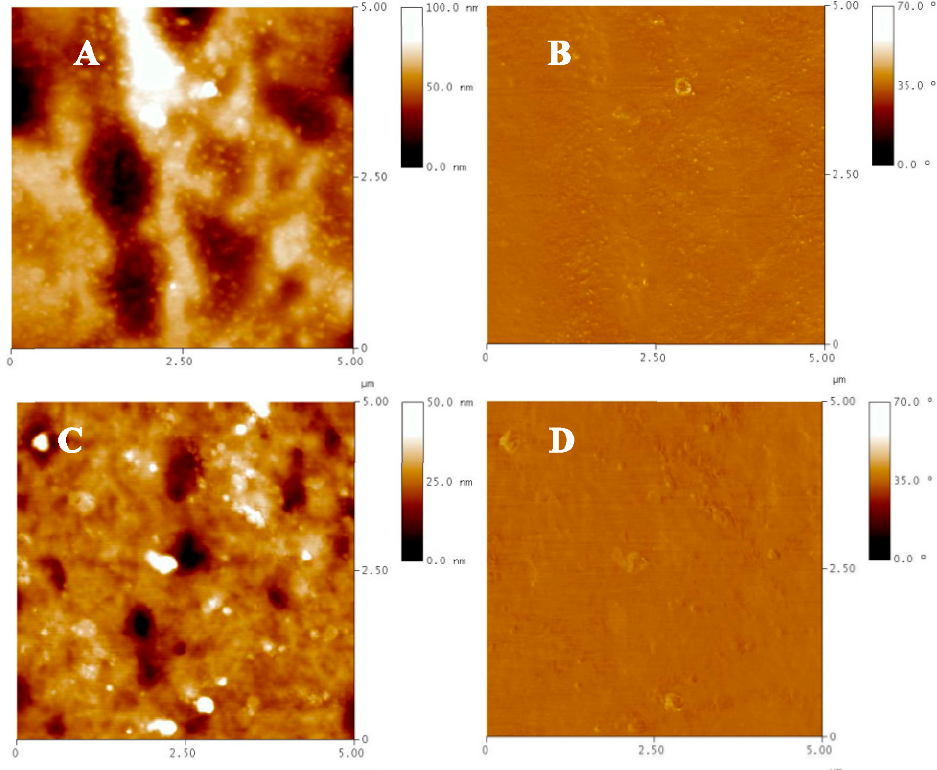
Figure 6. Topography and phase AFM images of ZnO-doped PMP ( A , B ) and bare PMP ( C , D ) films detected by scanning 5 × 5 µm 2 -sized areas.